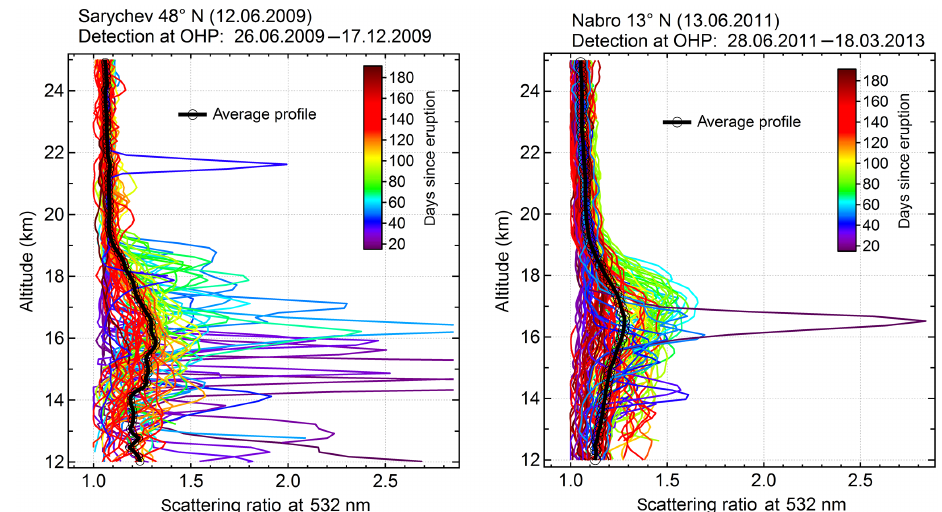
Figure 4. Individual (colored curves) and period-averaged (black circles) scattering ratio profiles from the OHP LiO3S lidar acquired after the eruptions of Sarychev (left) and Nabro (right) volcanoes. The colors of individual profiles denote the days since eruption. The eruption dates and plume detection periods are indicated in each panel. Only the data above the local tropopause (NCEP) are shown.